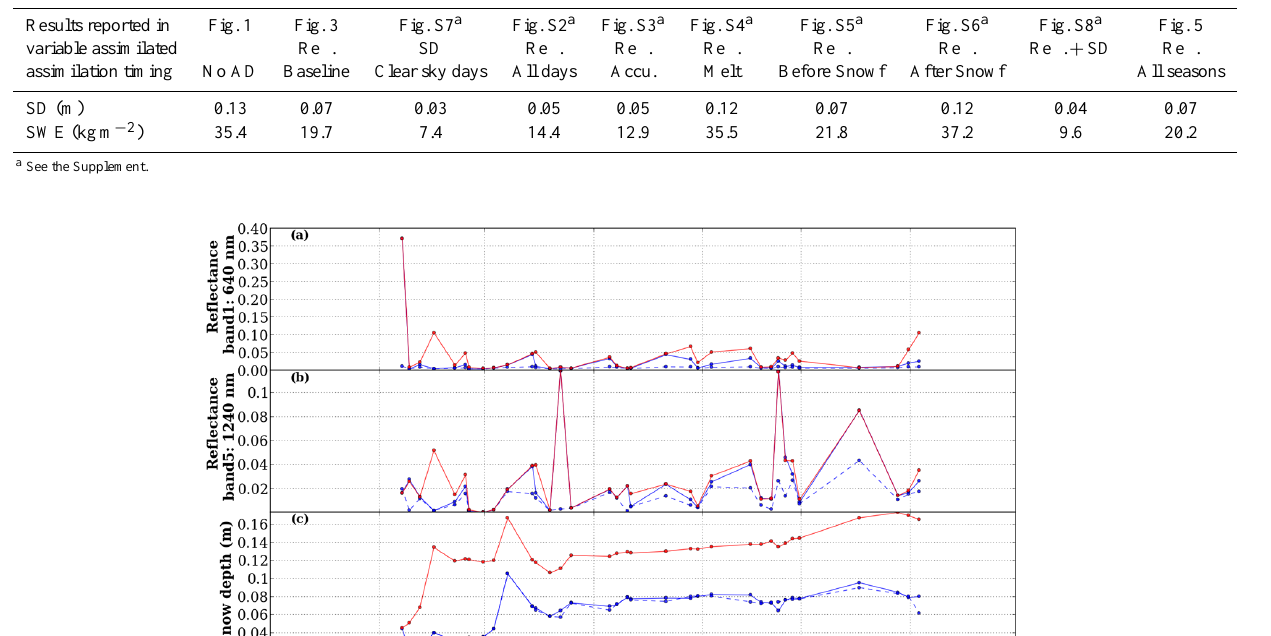
Table 2. SD and SWE seasonal averaged RMSE computed with respect to the synthetic truth for all experiments over the 2010/2011 season. Results reported in Fig. 5 are the RMSE computed over the five selected seasons.